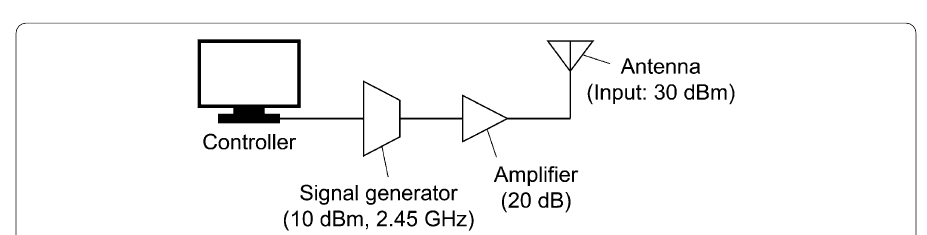
Fig. 4 Antenna powering setup for temperature measurement. Reprinted from (Mukai & Suh